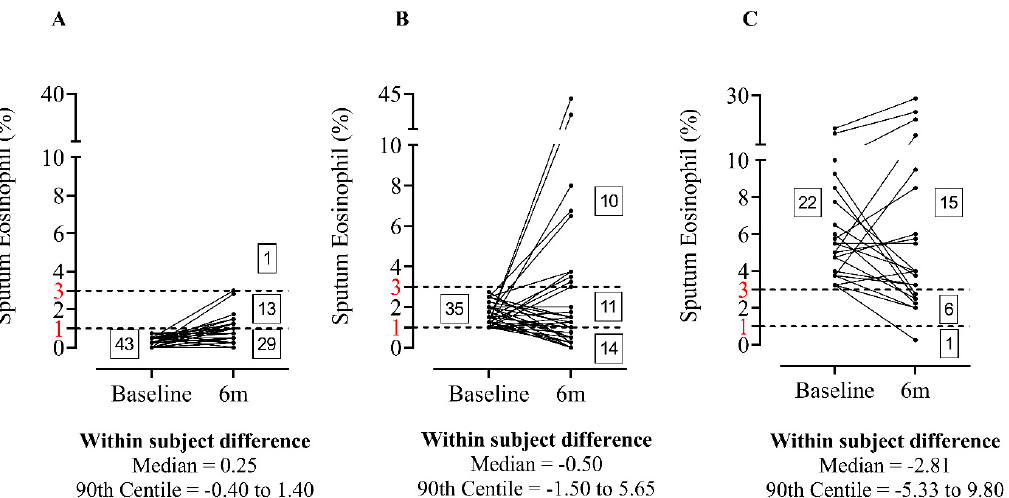
Figure 2. Stability of sputum eosinophils stratified by baseline sputum eosinophil %; Eosinophil LOW ( A ), Eosinophil INT ( B ) and Eosinophil HIGH ( C ), horizontal dashed lines and red numbering represent represent thresholds of 1 and 3% sputum eosinophil indicative of eosinophil LOW and eosinophil HIGH groups respectively. n = 43, 35 and 22 respectively.